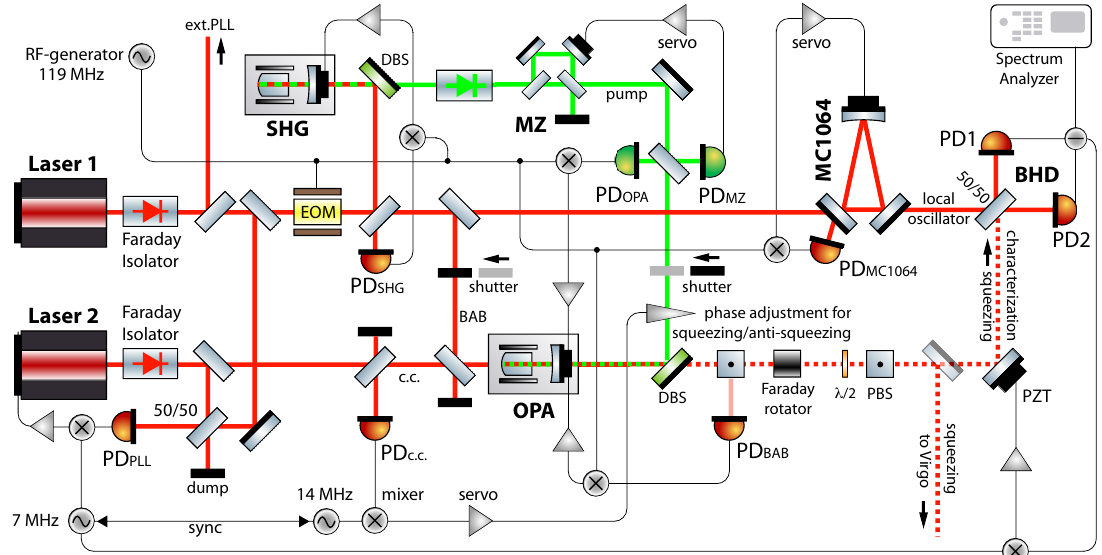
Figure 2. Schematic of the experiment. The generation and the coherent control of squeezed vacuum states of light at a wavelength of 1064nm are realized by utilizing two independent but frequency offset locked laser sources. Laser 1 provides the main carrier frequency for homodyne detection and frequency doubling in a second harmonic generator (SHG), which provides the pump field at a wavelength of 532nm required for the generation of squeezed vacuum states in an optical parametric amplifier (OPA) operated below threshold. The green pump power is stabilized by a Mach–Zehnder interferometer. The squeezed vacuum states exit the OPA and are separated from the pump field by a dichroic beamsplitter (DBS). A Faraday isolator is installed in the squeezing path. It protects the OPA from backscattered light and suppresses retro-reflections into the interferometer or the BHD. By means of an HR mirror mounted on a motorized translation stage the squeezing is either directed towards the application or onto the balanced homodyne detector (BHD) for characterization. The phase of the green pump, as well as the phase between the squeezed field and the LO, are stabilized by the implementation of a coherent control scheme based on the 7MHz frequency shifted Laser 2 output